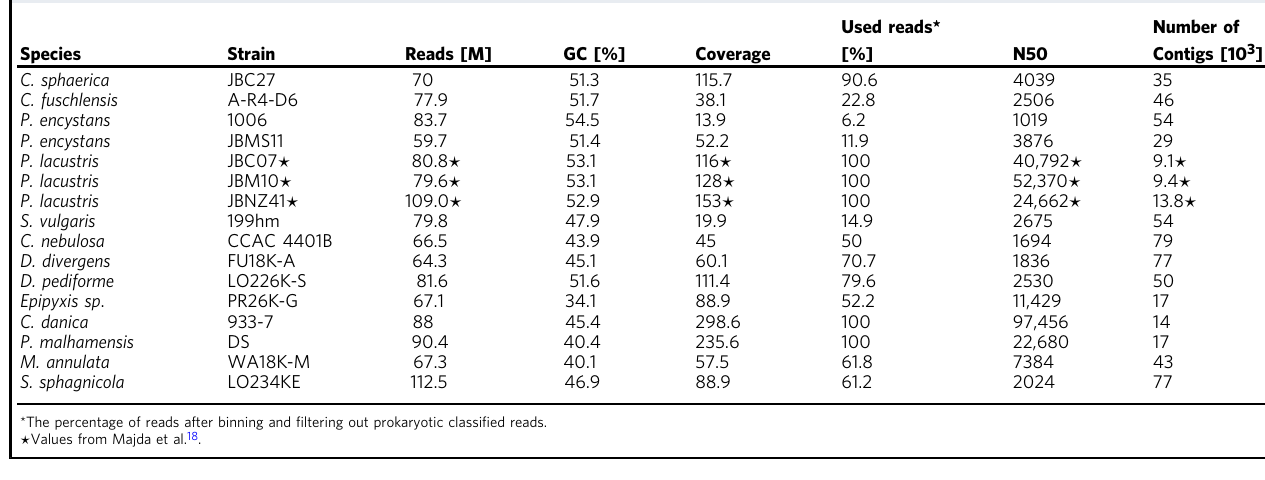
Table 1 Sequencing and assembly